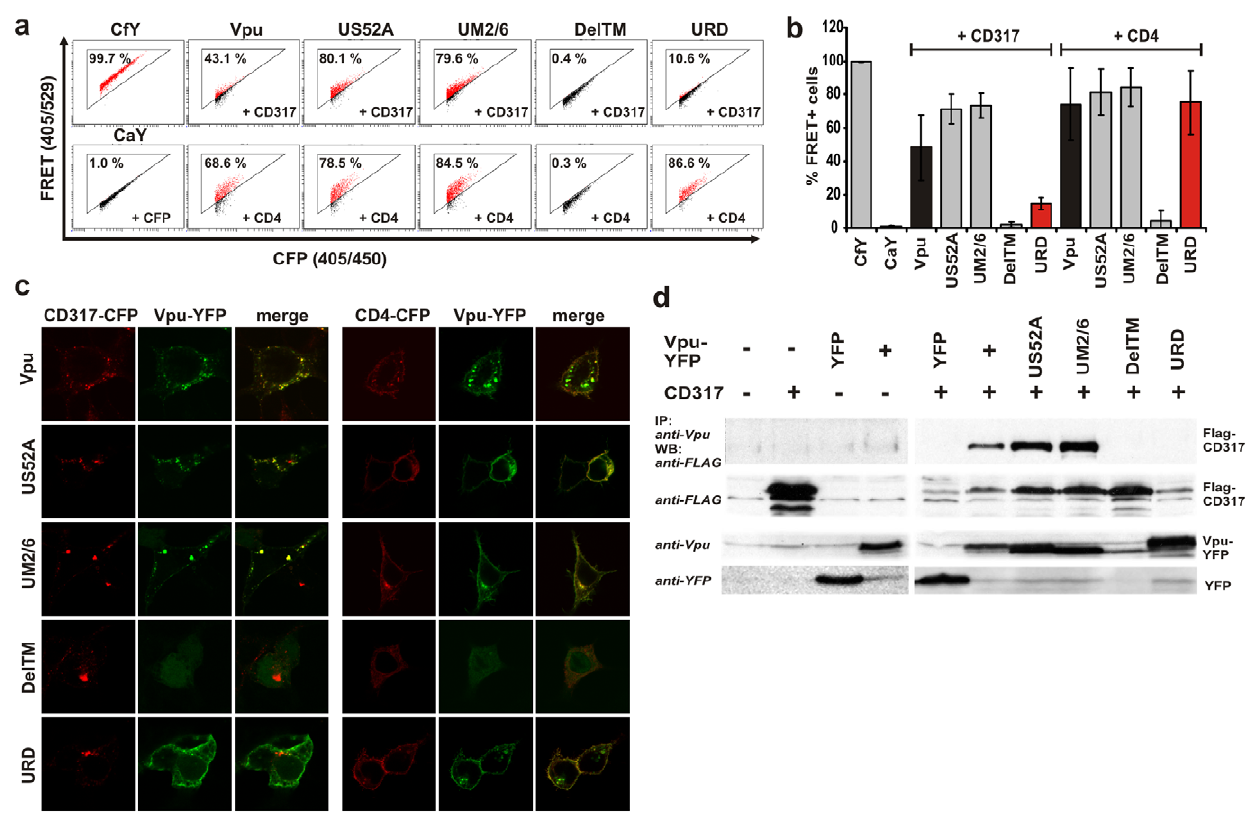
Figure 3. Vpu interacts with CD317 via its transmembrane region. (a) Representative primary FACS-plots showing the amount of FRET + cells in living 293T cells cotransfected with the indicated CD4 or CD317-CFP and Vpu-YFP fusion proteins. (b) Mean values and standard deviations (SD) for the total amount of FRET + cells from six independent experiments that were analysed as depicted in (a). (c) Confocal images of 293T cells that were cotransfected with the Vpu-YFP fusion proteins (shown in green) and either CD317-CFP or CD4-CFP (shown in red). (d) 293T cells were transfected with the indicated Vpu-YFP fusions and a FLAG-tagged CD317. Vpu immune complexes were isolated from cell detergent extracts by immunoprecipitation with anti-Vpu rabbit serum and analysed for the presence of CD317 by Western blot with anti-FLAG.